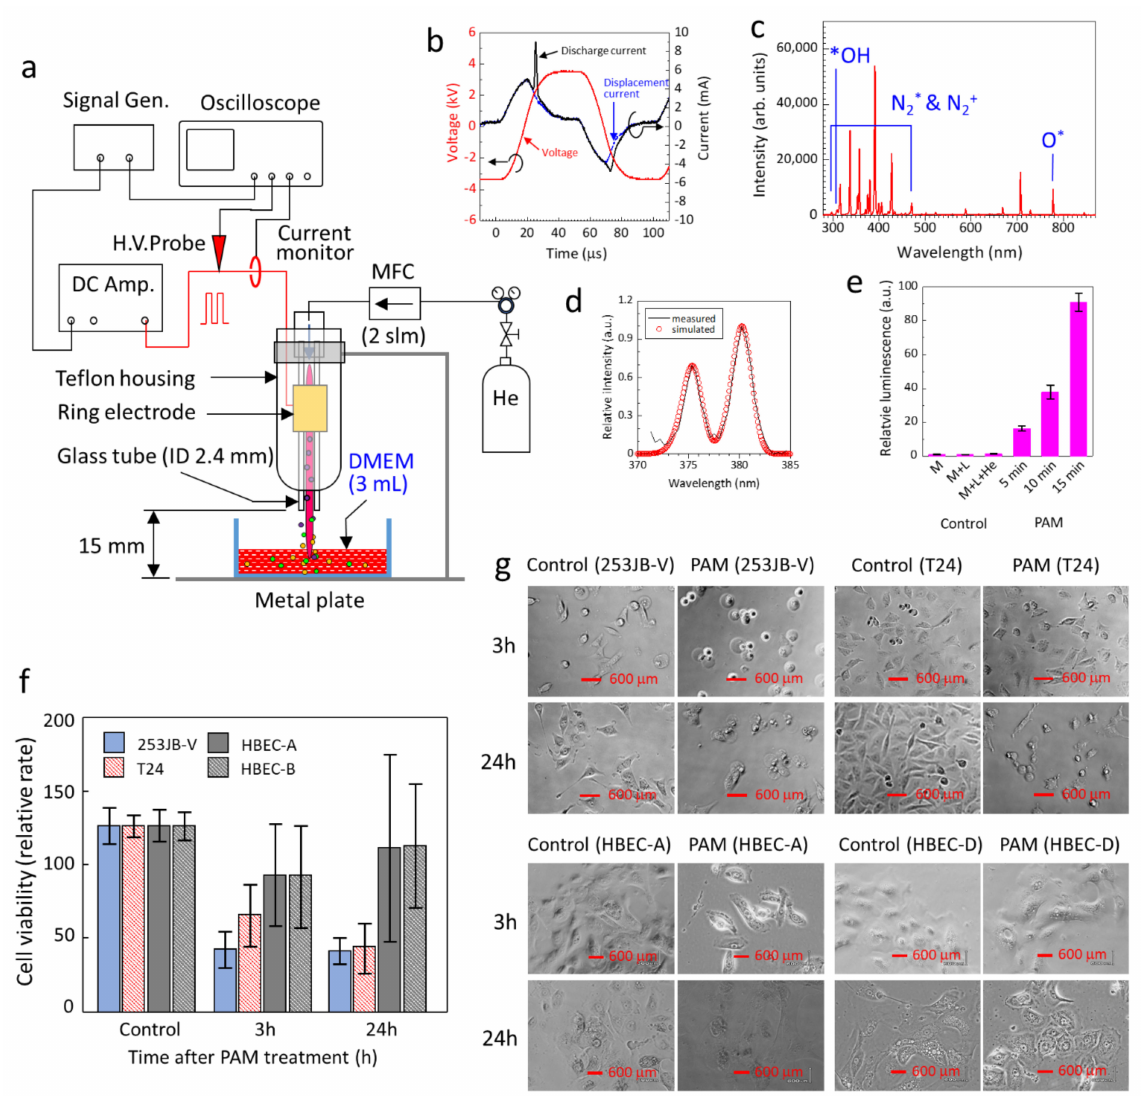
Figure 1. Overview of the procedure to prepare PAM for treatment of bladder cancer cells. ( a ) Set-up and procedure used to prepare PAM. ( b ) Electrical and ( c ) optical emission characteristics of the plasma jet and ( d ) the measured and simulated spectrum of the N 2 second positive system. ( e ) The rel- ative luminescence of luminol in PAM compared to untreated DMEM, which was used to compare the relative level of ROS; controls: M = media; M + L = media with luminol; M + L + He = media with lu- minol treated with helium gas alone. ( f ) Cell viability of cancer versus normal bladder cells following PAM treatment; Control = untreated cells measured at 24 h after the PAM treatment. ( g ) Micrographs of the typical cancer and normal bladder cell morphology before and after PAM